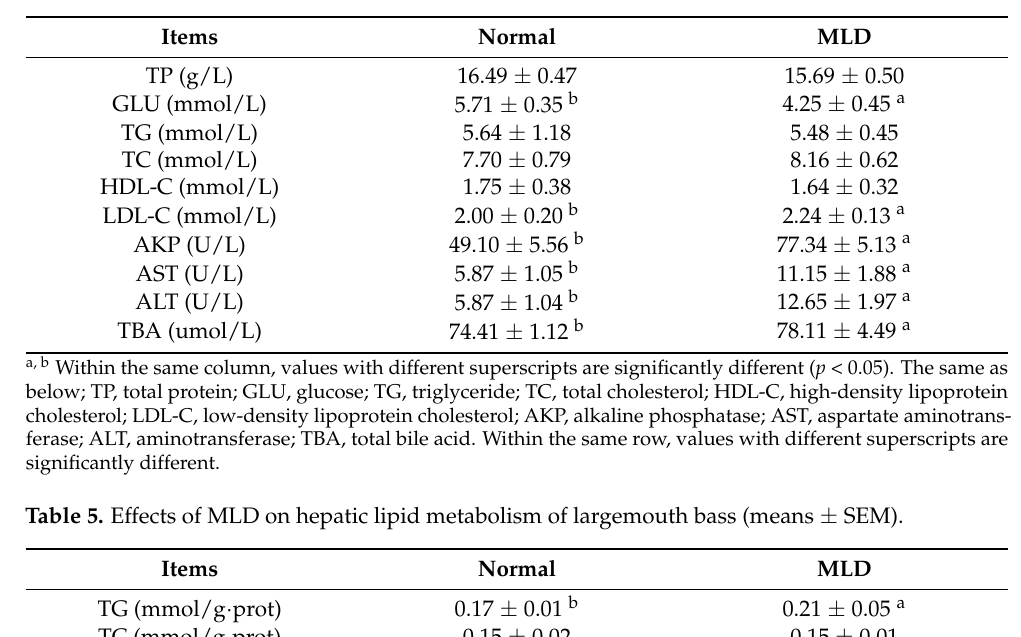
Table 4. Changes of MLD on plasma liver function parameters of largemouth bass (means ± SEM).